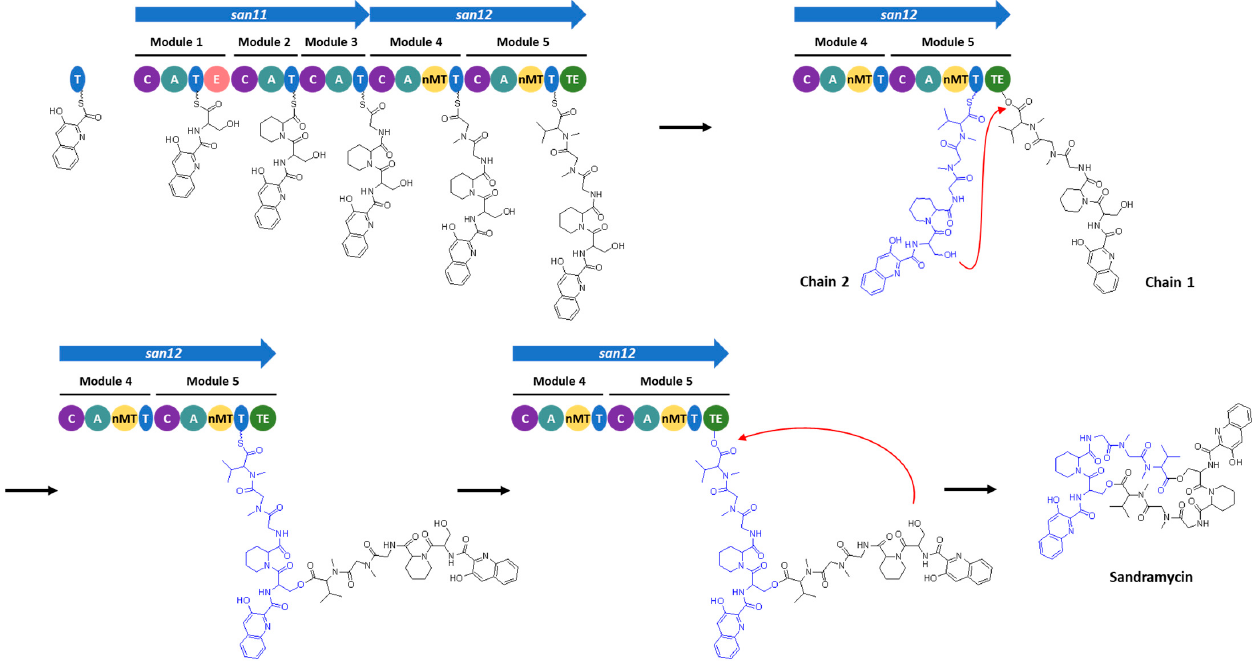
Figure 6. Proposed NRPS assembly line of sandramycin: two identical peptide chains are synthesized, and the T-bound PK/NRP chain is proposed to attack the thioester of the second chain tethered to the TE domain, sending it “backwards” to the ACP domain. The linear dimer is then returned to the active site of the TE domain for macrocyclization.